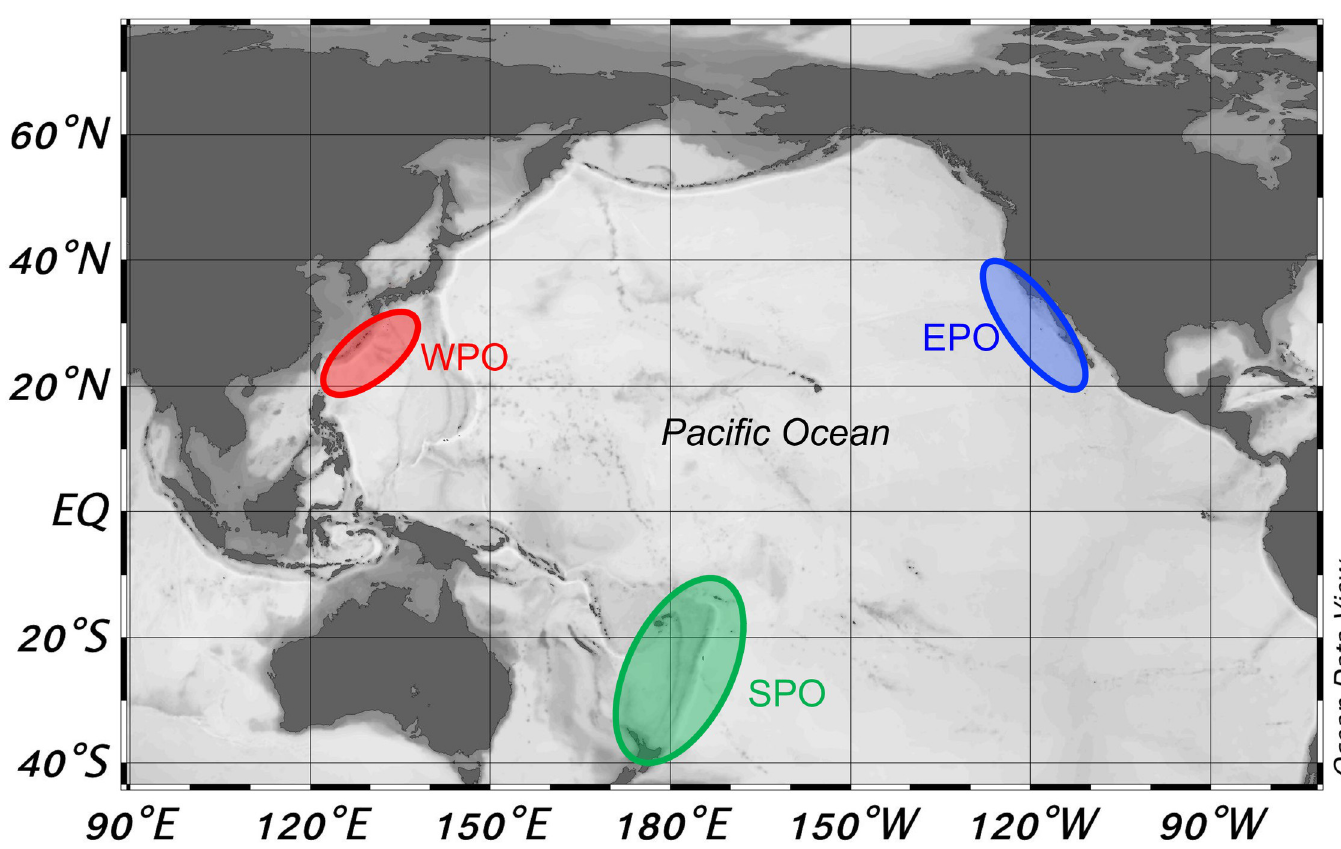
Fig 1. Geographical map of opportunistic collected PBT otoliths samples from the eastern Pacific (EPO), western Pacific (WPO) and south Pacific (SPO); different colored ellipses represent approximate collection regions.